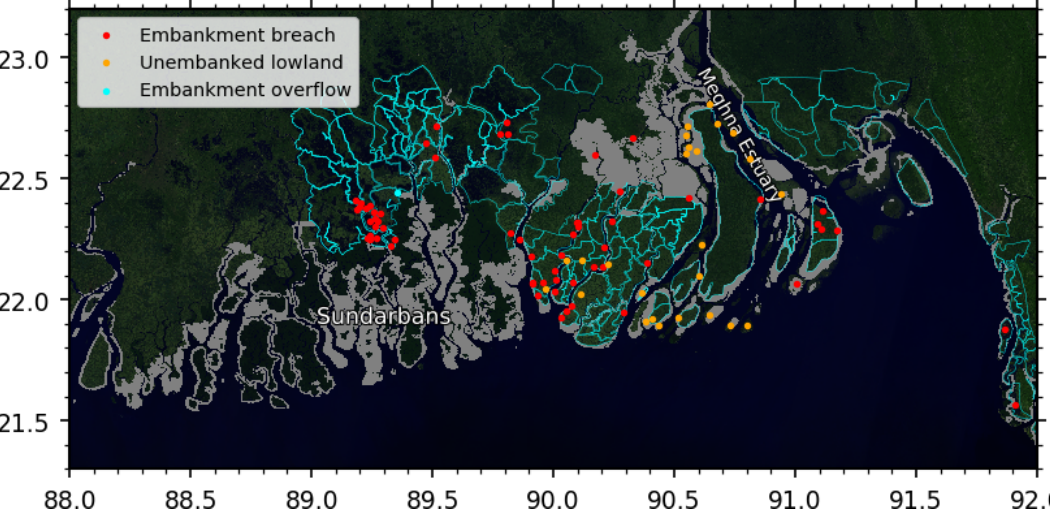
Figure 9. Digitized location of inundation resulting from embankment breaching (red), flooding of low-lying unembanked area (orange), and embankment overflow (cyan) overlaid on a false-colour image composite derived from B12, B11, and B4 channels of Sentinel-2 during April 2020. The grey patches are the inundated regions predicted by the model, as shown in the hindcast experiment. The polders are shown with cyan